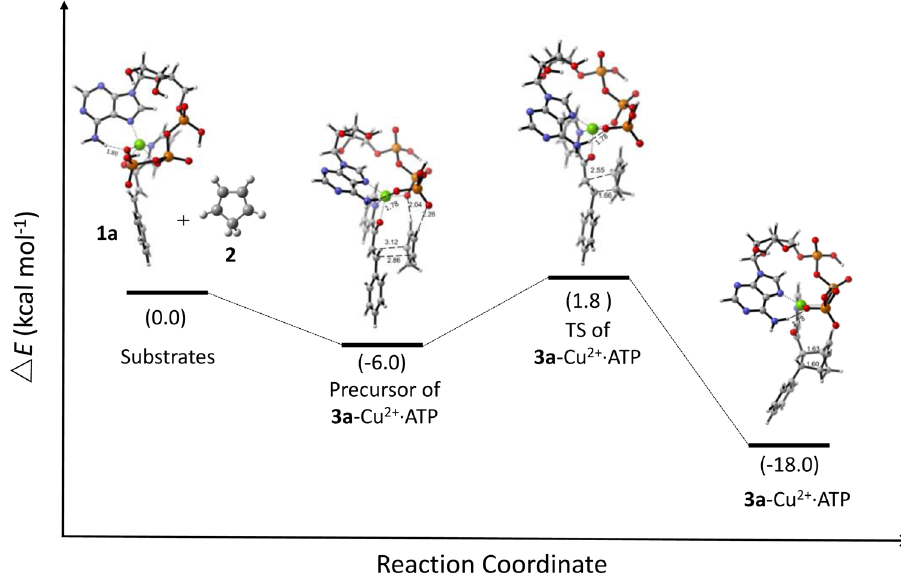
Supplementary Fig. 25. The relative electronic energy pro fi le of the reaction path for Cu 2 + ⋅ ATP-catalyzed Diels – Alder reaction of 1a and 2 that yields 3a (endo) in the absolute con fi guration of 1R, 2S, 3S, 4S. TS, transition state. The HTML has been updated to include a corrected version of the